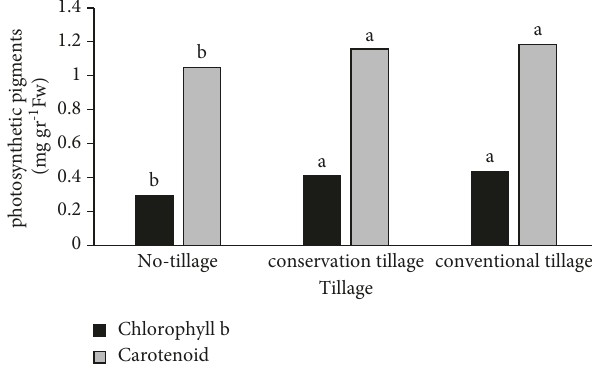
Figure 3: The effect of tillage methods on chlorophyll b and